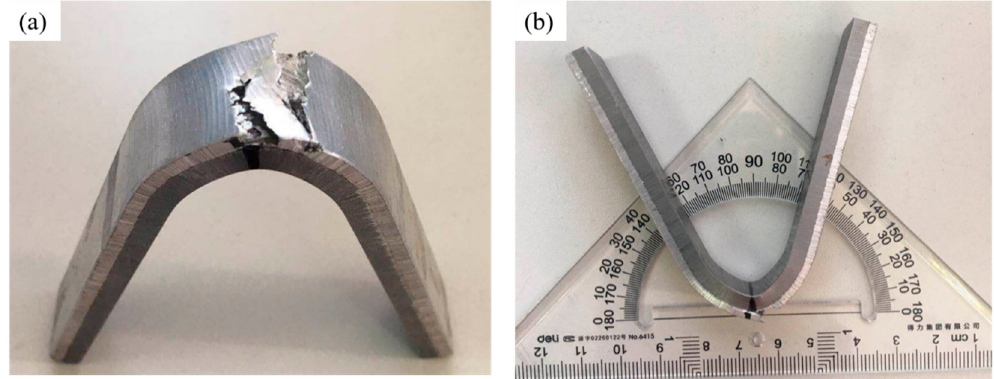
Figure 12. Bending specimens of composite plate after FSP with four passes: ( a ) tensile face; ( b ) bending diagram of angle measurement.